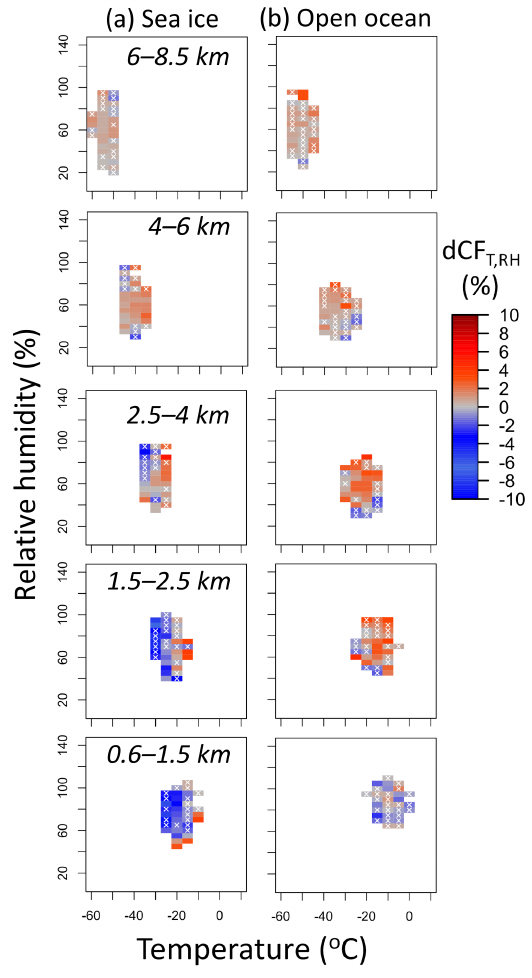
Figure 1. An example of d CF T, RH output at each altitude level over (a) sea ice and (b) open ocean. For illustration purposes, here each grid cell represents ≥ 7500km 2 of gridded observations. Blue and red colors indicate negative and positive d CF T, RH , respectively. A white X indicates that the cell value is not significantly different from zero (Wilcoxon rank test, p <0.05). Note that each underlying Wilcoxon rank test has a 5% chance of yielding a false positive indication of statistical significance or an unknown (but likely much higher) chance of yielding a false negative result. Consequently, the distribution of Xs should not be over-interpreted. The number of Xs, however, provides an objective way to test whether the evidence for an effect on the grid as a whole is significant. This is consistently the case; in all panels, individually significant cells numbered more than expected at random (binomial test, p